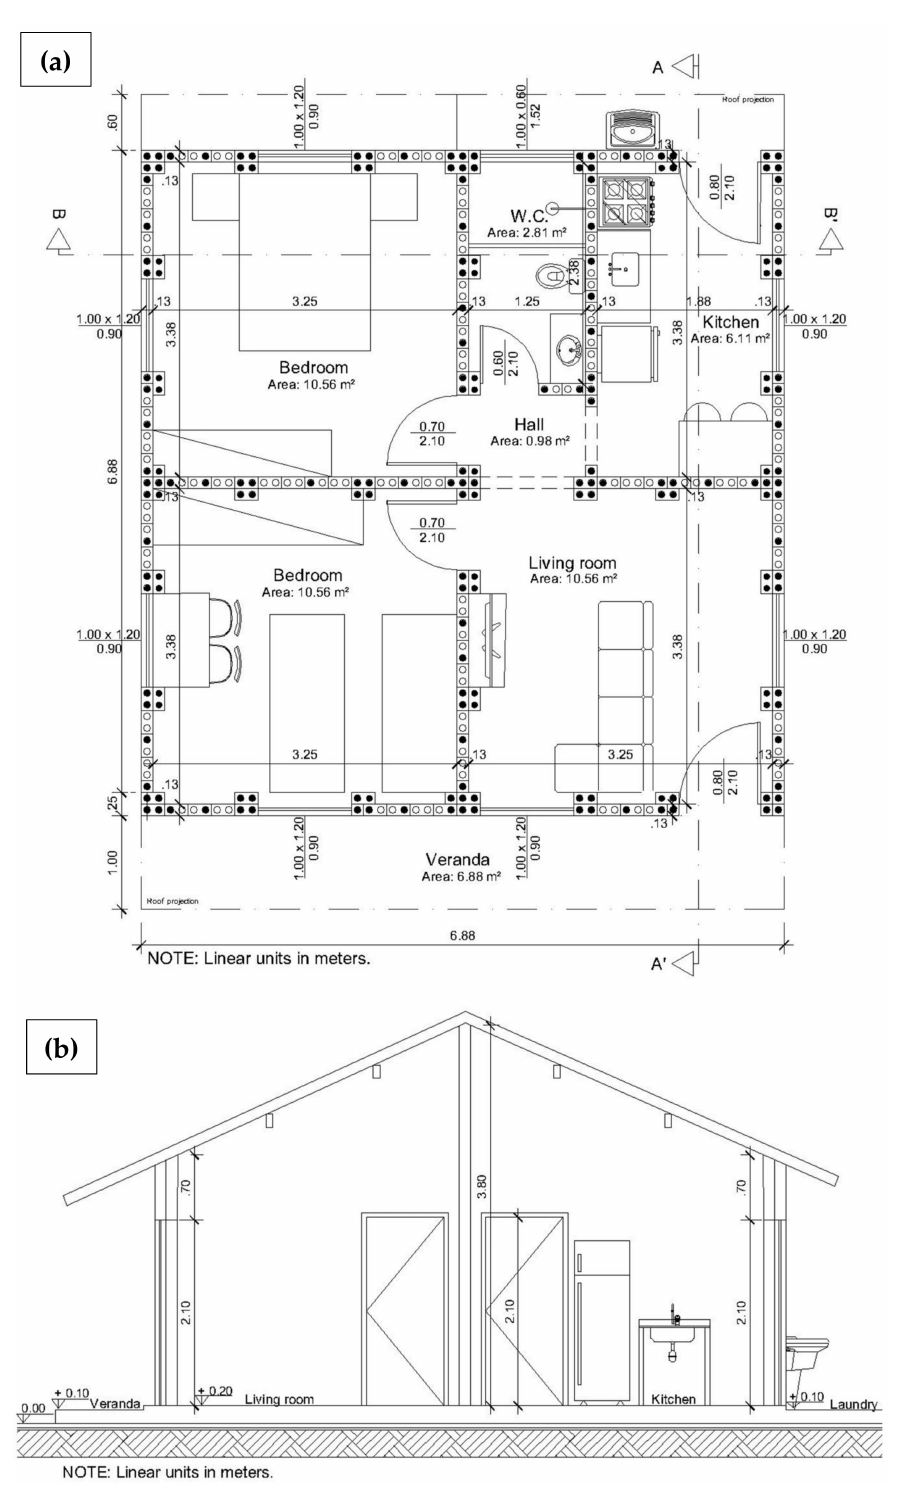
Figure 3. ( a ) Embryo 2C floor plan; ( b ) Section AA’